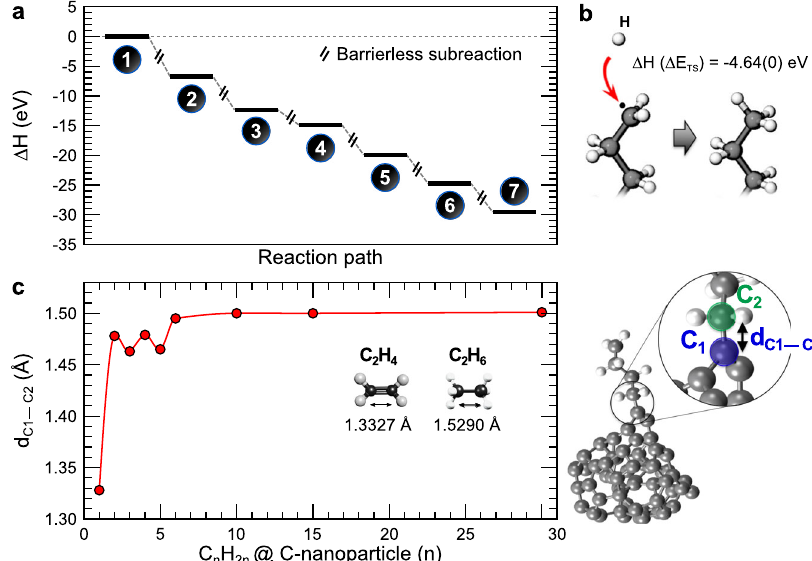
Fig. 3 DFT energy and bond-length calculations. a Computed enthalpy-variation diagram for each step in Fig. 1a along the reaction pathway. Enthalpy is given in eV, and all the subreactions are produced spontaneously with no thermokinetic reaction barrier. b Proposed mechanisms for interruption of the growth process after C 6 H 12 formation on a C-NP by capture of a H to form C 7 H 15 , and ( c ) DFT-resulting C – C-bond length (in Å) between the carbon atoms C 1 and C 2 binding the C-NP and the growing alkane as a function of the alkane length up to n = 30. C – C-bond lengths for the gas-phase C 2 H 4 and C 2 H 6 are also shown for comparative purposes. Electrophilic H attack at the C 1 – C 2 bond leads to gas-phase C n H 2 n + 2